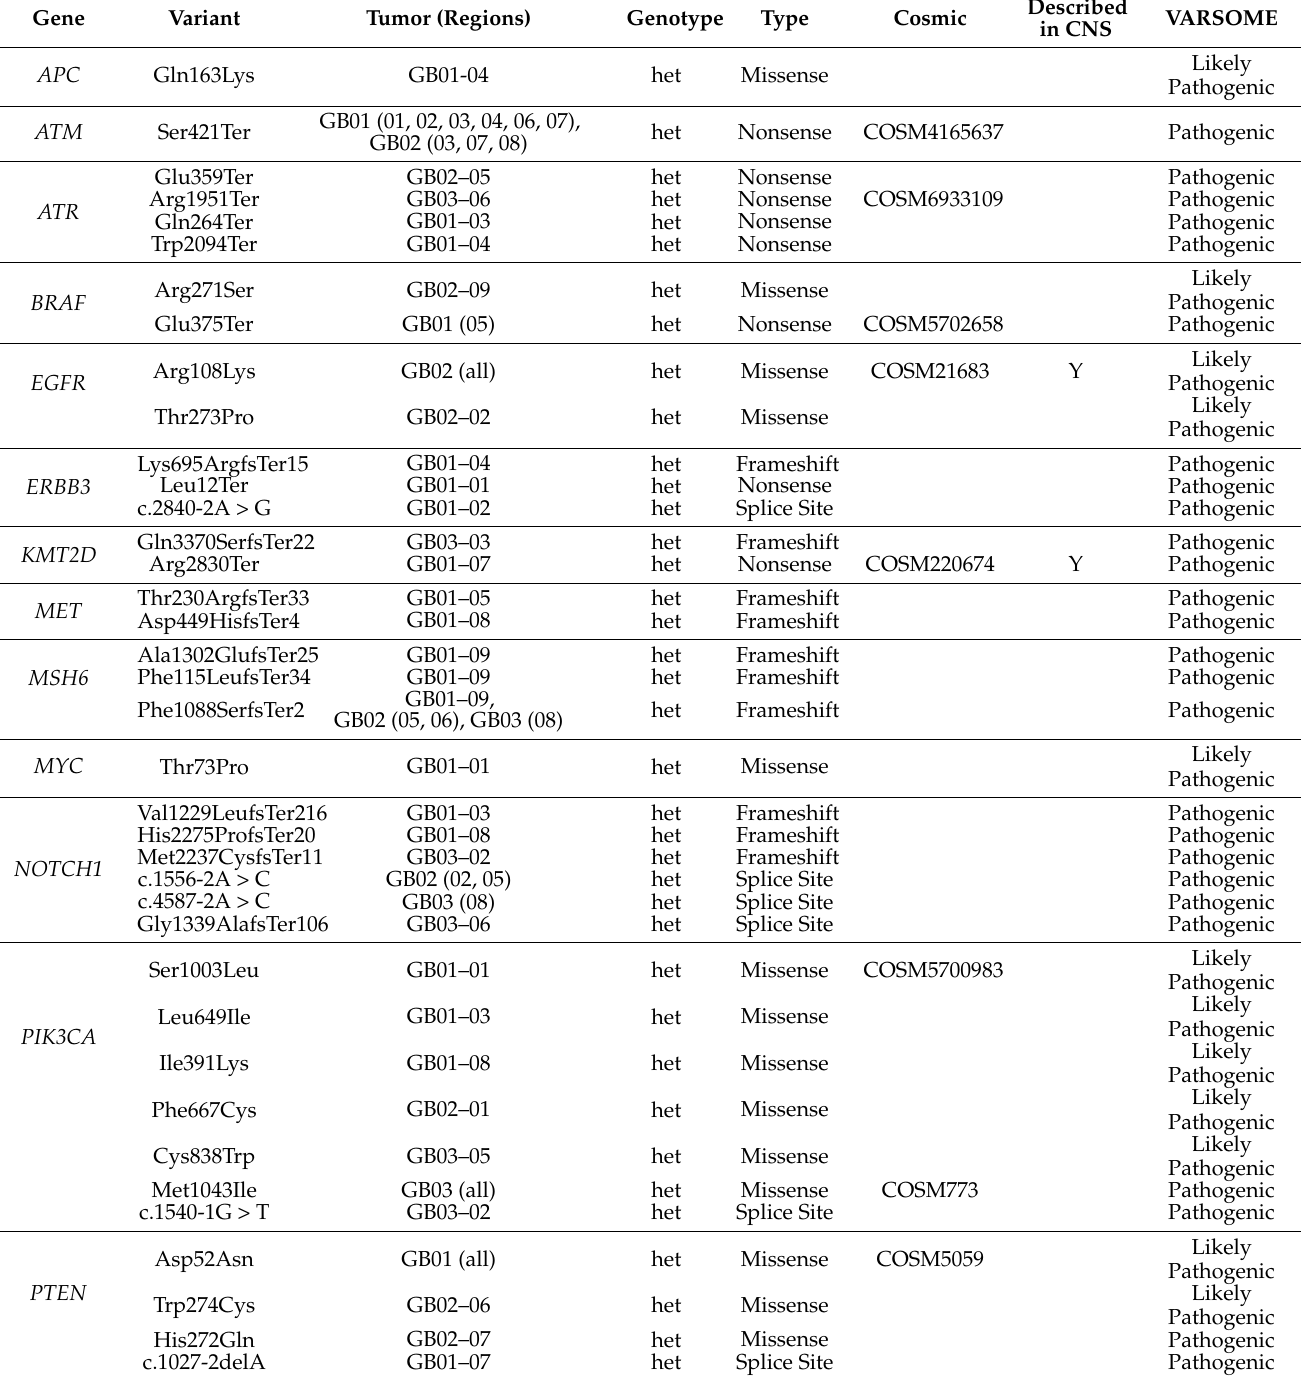
Table 2. Enrichment of pathogenic variants in GB01, GB02, and GB03 somatic mutations. Gene, mutated gene. Variant, amino acid change or base substitution. Tumor (regions), tumor regions in which that mutation was detected. Genotype, heterozygous (het) or homozygous (hom) mutation. Type, type of genetic mutation. COSMIC, mutation already noted in the Catalogue of Somatic Mutations in Cancer (COSMIC). Described in CNS, variants that have already been described in brain tumor and annotated in COSMIC. Varsome, functional prediction of each variant classified using American College of Medical Genetics and Genomics (ACMG)